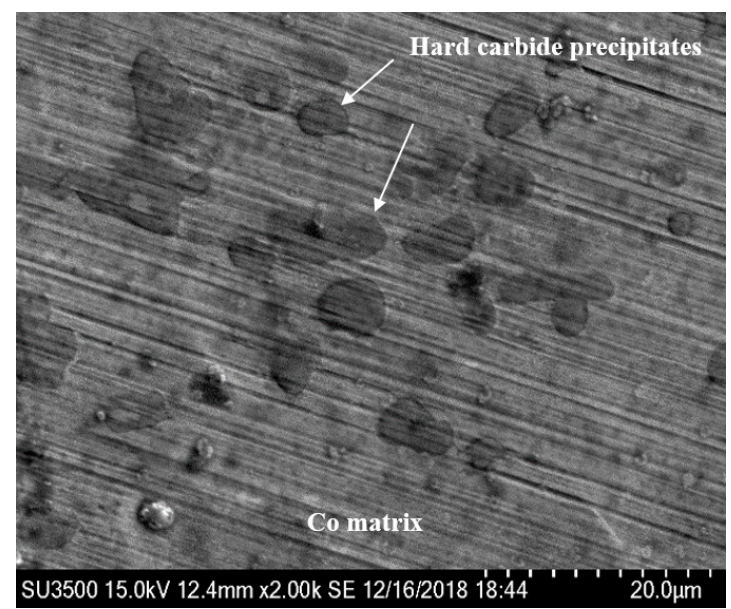
Figure 15. Micromorphology of stellite alloy surface without water droplet erosion.